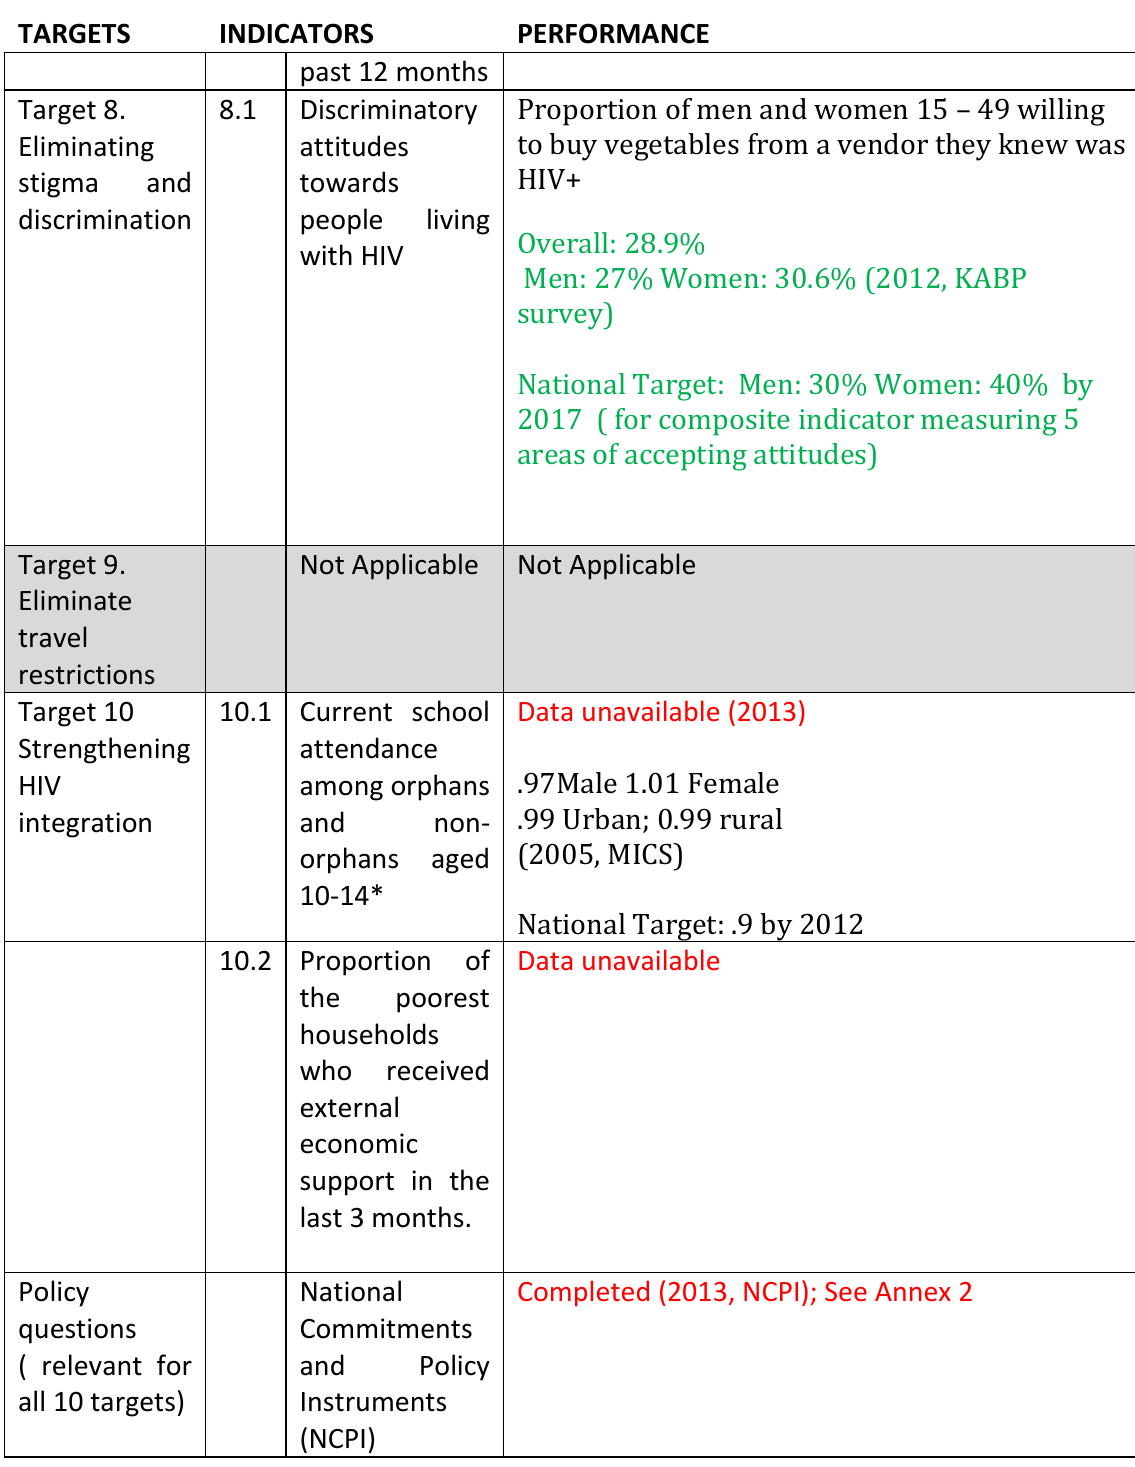
Table 1: Core Indicators for 2011 Political Declaration on HIV and AIDS, Jamaica Data January 2012 – December